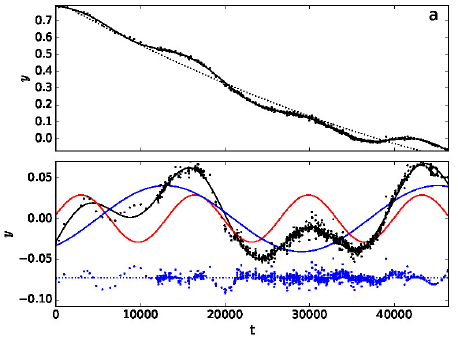
Fig. 13.— Model for XZ And data. Otherwise as in Fig. 3. lines in Fig. 11.